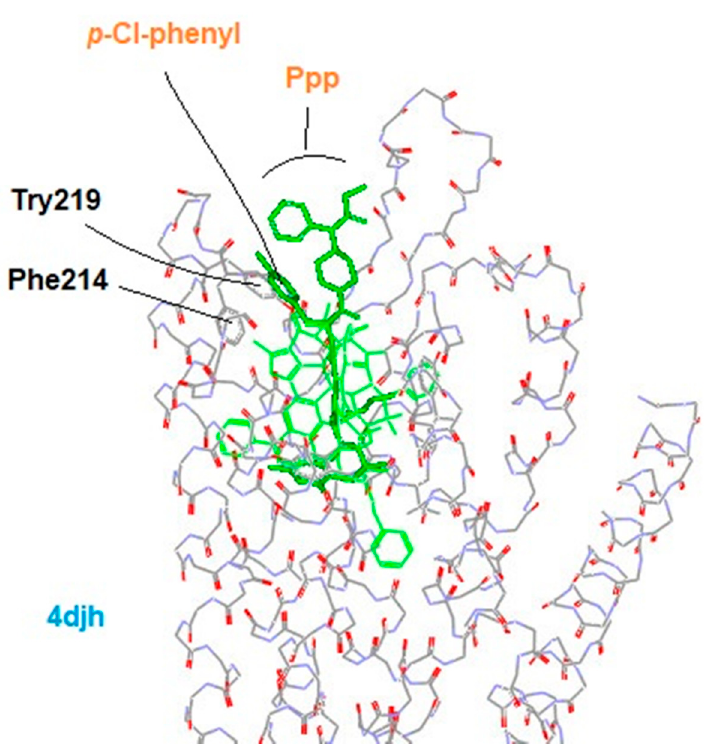
Figure 4. Docking of 6 as aligned with the template (light green) onto the binding pocket of a KOR-JDTic complex (4djh).